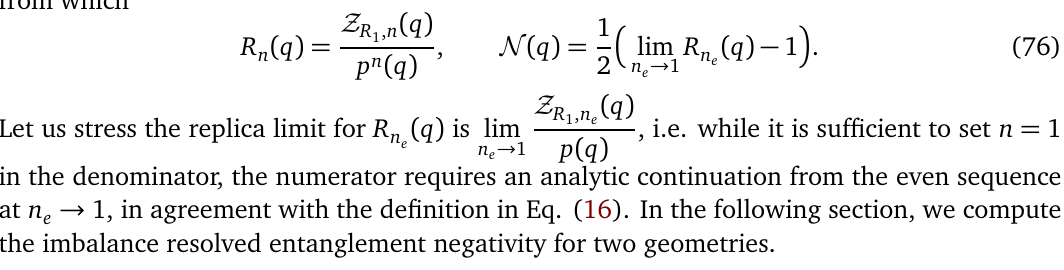
1 the grey one on the right, of length (cid:96) and (cid:96) 2 1 2 . For each branch 1 going around k